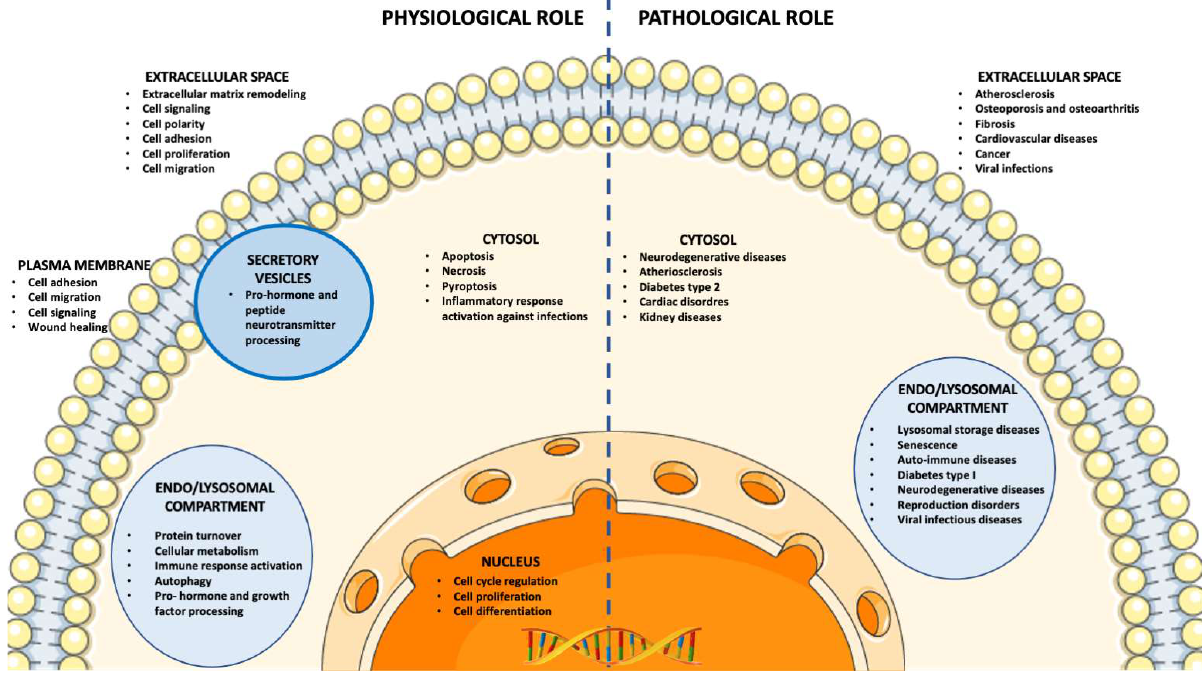
Figure 1. Physiological and pathological roles of cathepsins depending on their localization at a specific cellular